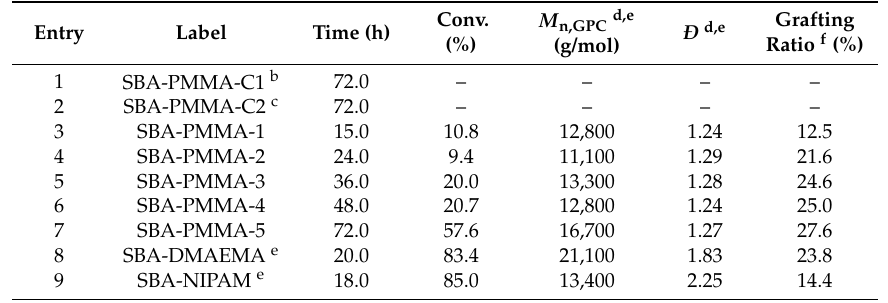
Figure 2. XPS spectra of SBA-15, SBA-APTES, SBA-Br, and SBA-PMMA. Table 1. Results of photo-induced metal-free SI-ATRP of MMA using SBA-Br as an initiator a